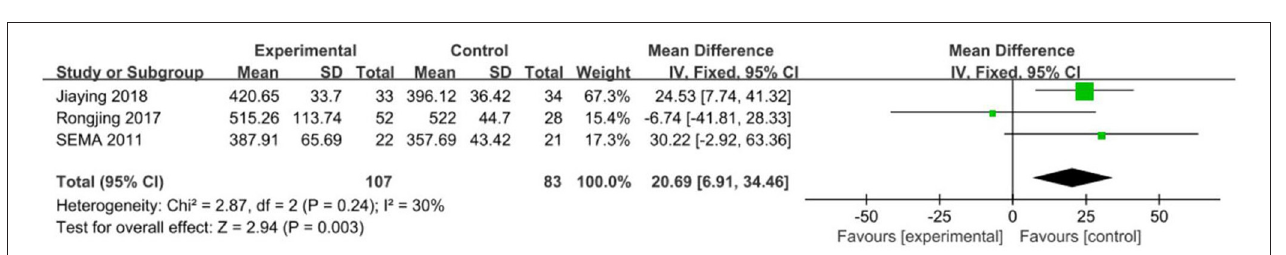
FIGURE 8 | Meta-analysis: a 6-minute walk trial of exercise therapy in patients with coronary heart disease.